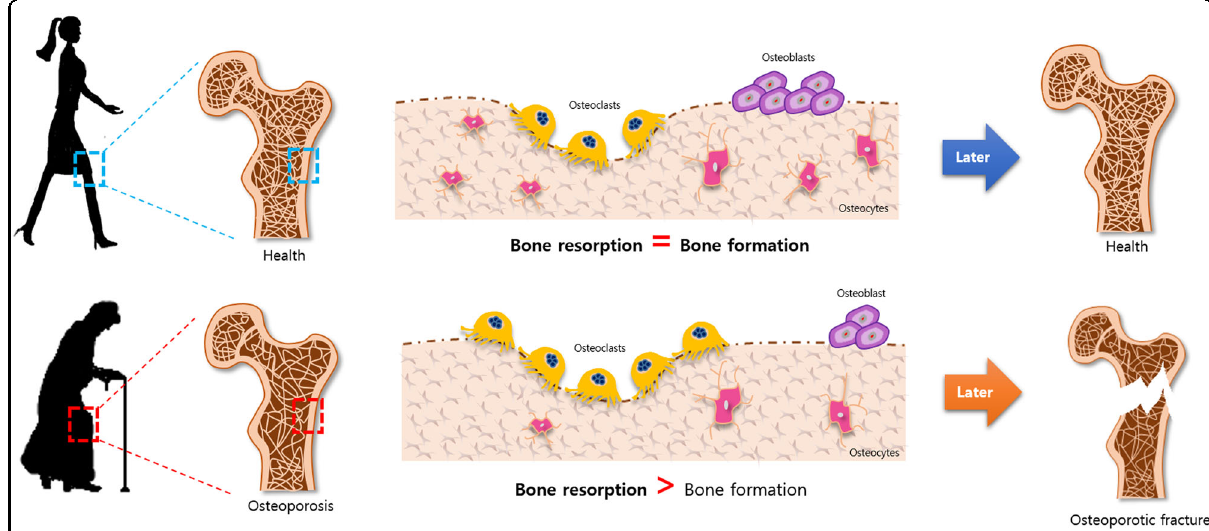
Fig. 1 Bone remodeling. Bone formation and resorption are mainly regulated by the interplay between osteoblast differentiation and osteoclast activation. With increasing age, the balance shifts to more bone resorption than bone